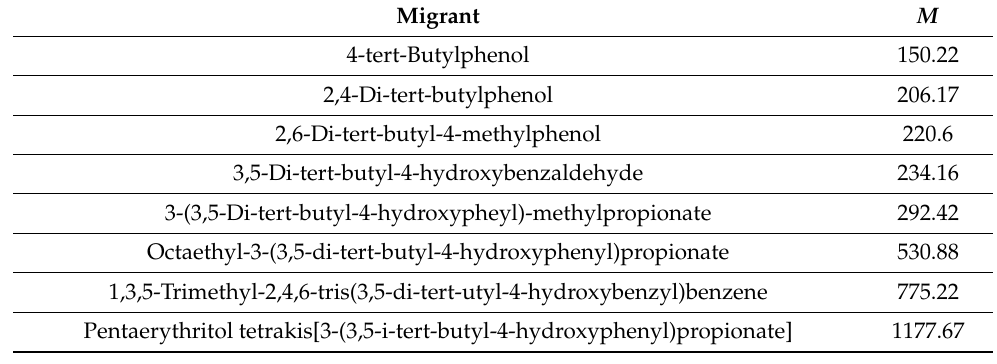
Table 8. Additives with relative molecular masses M used in HDPE and their diffusion coefficients represented in Figure 12 [44].